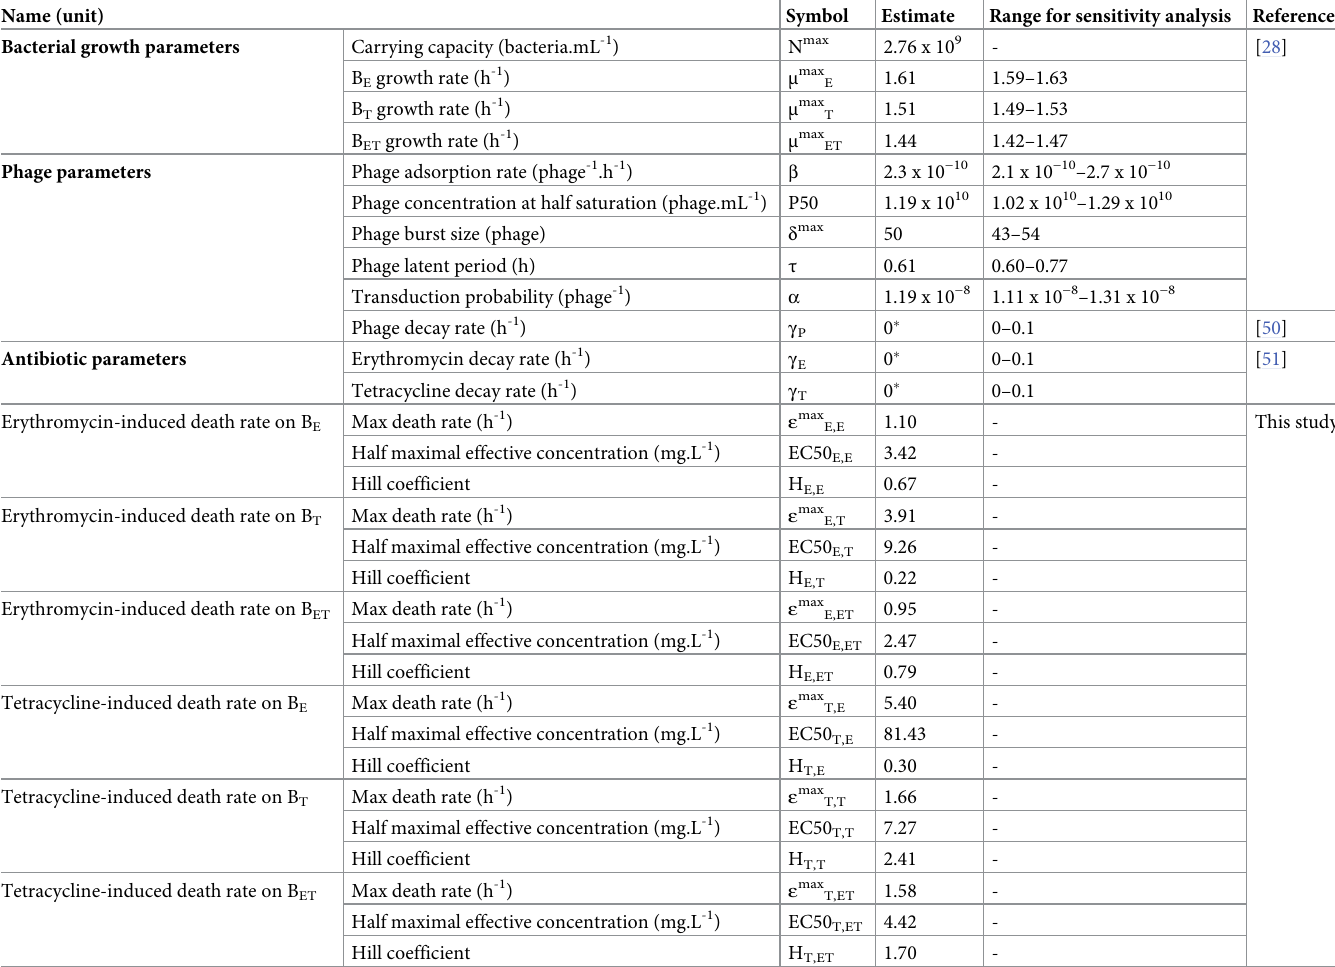
Table 1. Model parameter values. Parameters with no units are dimensionless. All estimates were obtained by fitting the model to in vitro data, except those marked with a � which are